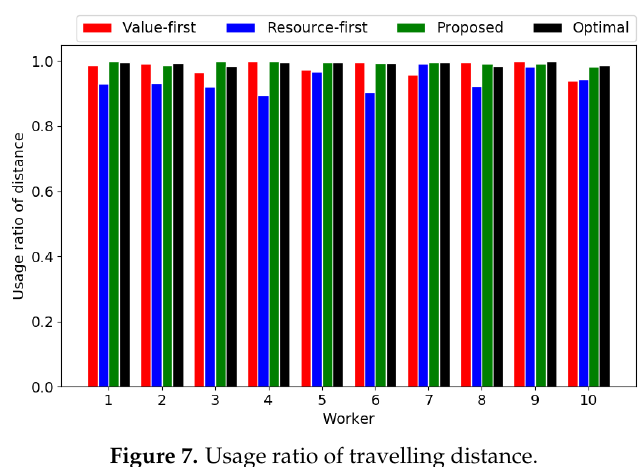
Figure 6. Paths of different algorithms.